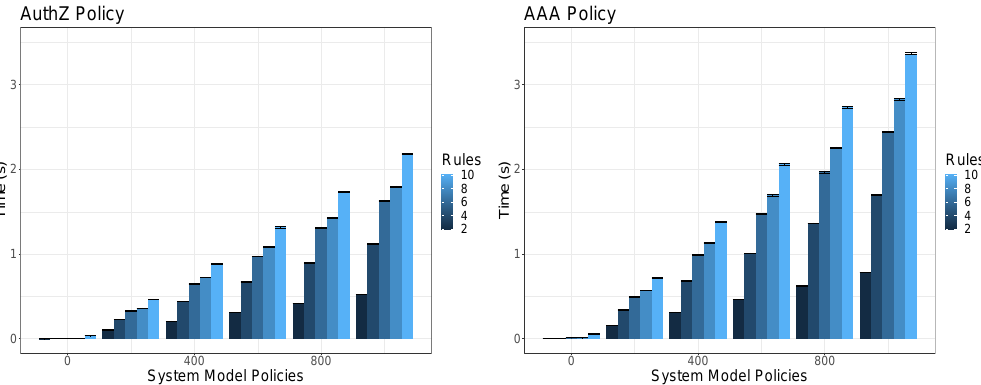
Figure 8. Conflict detection performance of Authorisation and AAA policies according to the